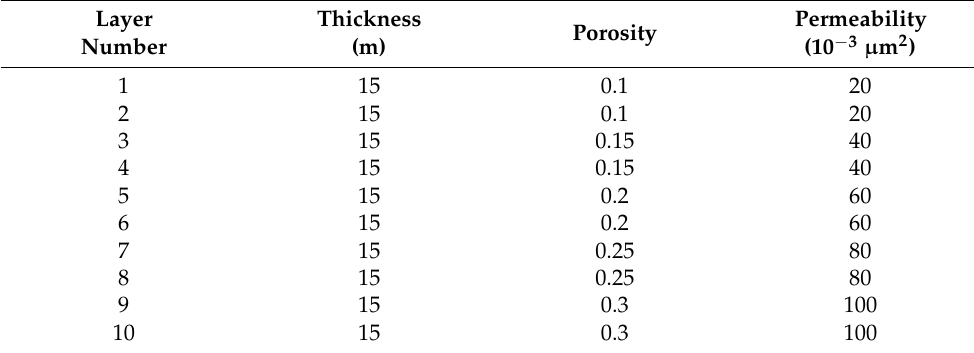
Table 8. Basic information of each layer in two-dimensional numerical